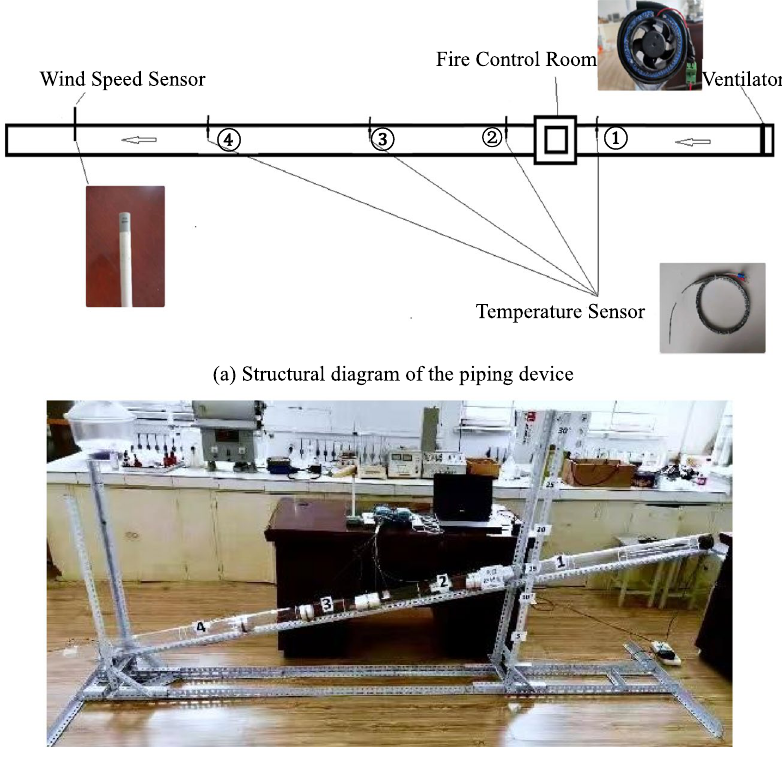
Figure 1. Single pipe test rig (device) for mine fire experiments.